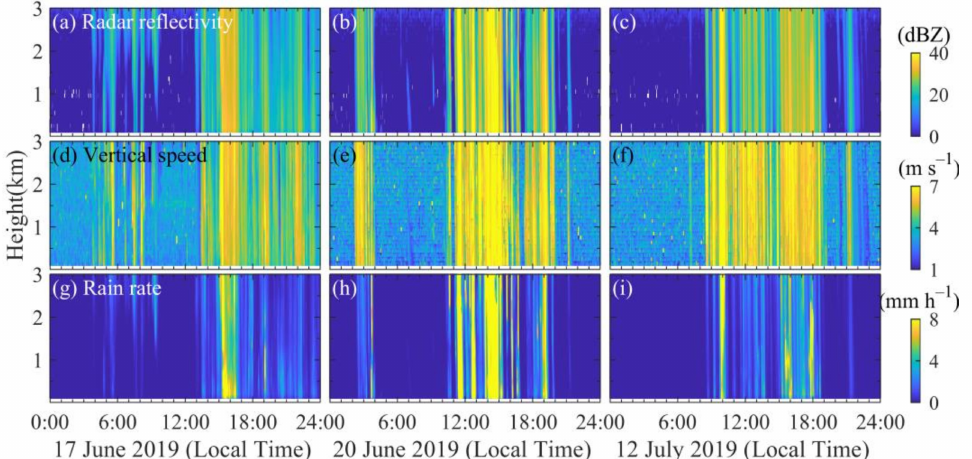
Figure 2. Precipitation processes observed by the MRR on 17 June 2019, 20 June 2019, and 12 July 2019. ( a – c ), radar reflectivity. ( d – f ) vertical velocity. ( g – i ) rain